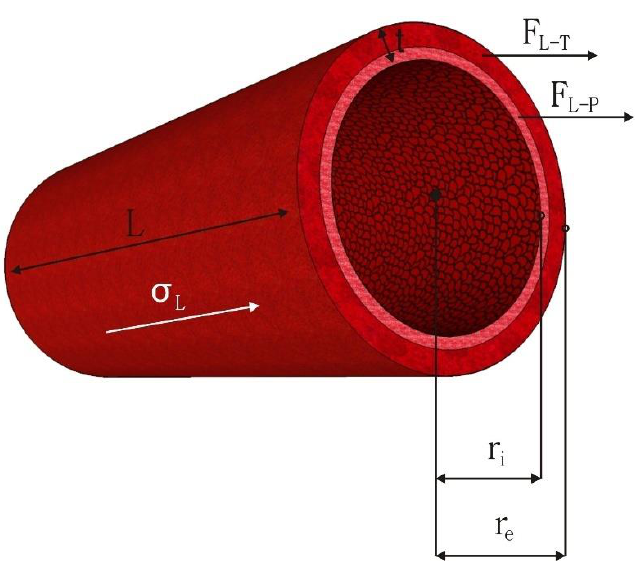
Figure 4. The dimensional variables of a vascular graft and longitudinal force components.